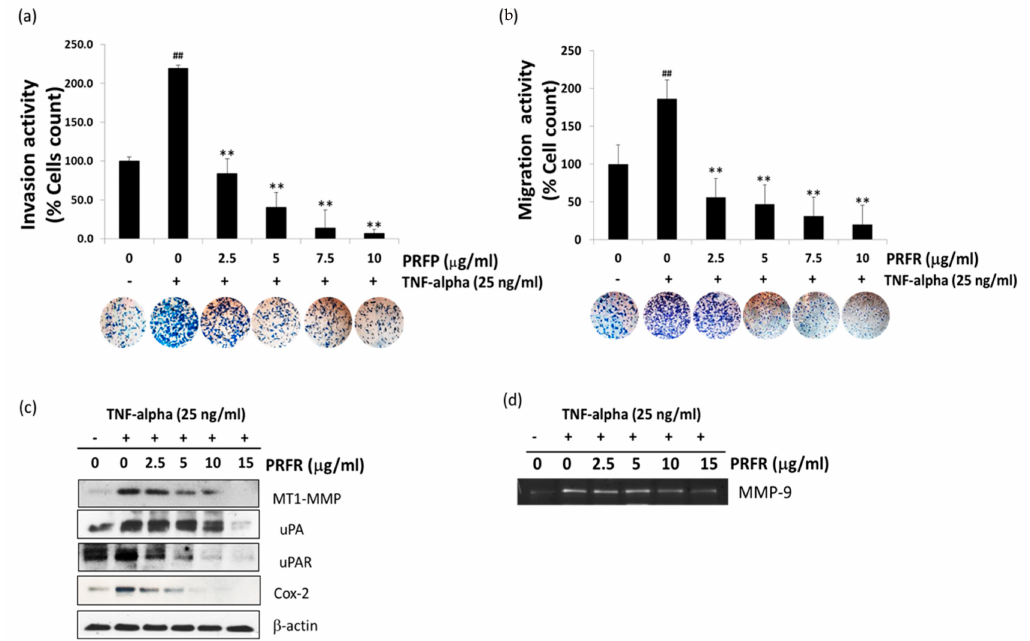
Figure 4. PRFR inhibits TNF- α -induced A549 cell invasion and migration. The matrix gel was coated on the upper surfaces of the membrane filters for invasion assay ( a ) and the gelatin was then coated for migration assay ( b ). Di ff erent concentrations of PRFR (0–10 µ g / mL) with 1.25 × 10 5 cells of the A549 cells were seeded into the upper chamber in DMEM serum-free medium, and the lower chamber was filled with 25 ng / mL of TNF- α . After 24 h of incubation, the migrated cells on the lower surface of the filter were determined. After co-treatment with PRFR and TNF- α for 24 h, whole-cell extracts were prepared and analyzed by western blot analysis using antibodies against metastatic proteins (MT1-MMP, uPA, uPAR, and COX-2) ( c ). The culture supernatants of the treated cells were collected, and the secretions of MMP-9 were analyzed by gelatin zymography ( d ). The data are presented as the mean ± S.D. of three independent experiments. Notably, ( a , b ) sample groups were found to be significantly di ff erent from the TNF- α -treated group (** p < 0.01) and the TNF- α alone compared with the control group ( ## p <